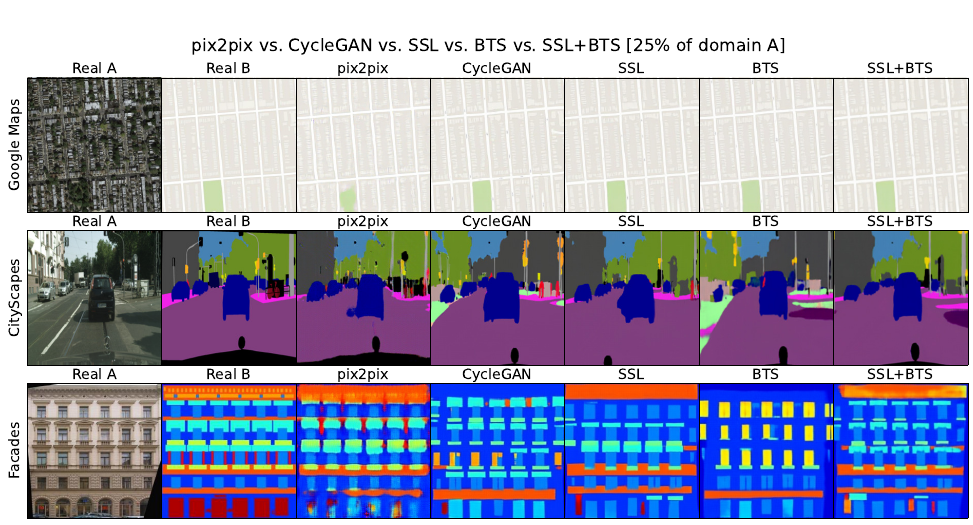
Figure 4. Visual examples of the proposed vs. baseline algorithm comparisons for 25% of the scarce domain data used: Real A (scarce domain) and Real B (target domain) correspond to image pair examples. Examples are given for Google Maps , CityScapes and Facade datasets. SSL denotes that only SSL on the control part of pared images is included in the training of CycleGAN, BTS denotes that only bootstrapping of the statistic of the A discriminator pool is included in the training, while SSL+BTS denotes that both SSL and BTS are included.